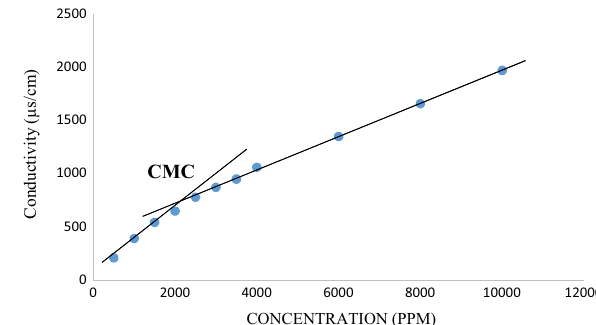
Fig. 3 CMC of SDS by conductivity calibration curve (distilled water)